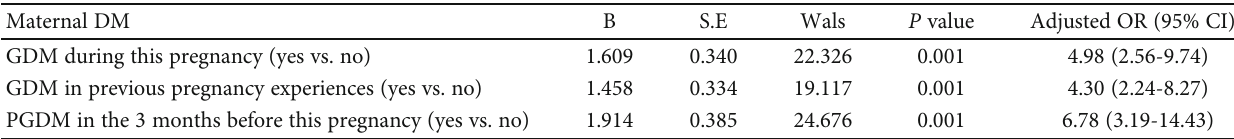
Table 3: Multivariate analysis of maternal DM and o ff spring